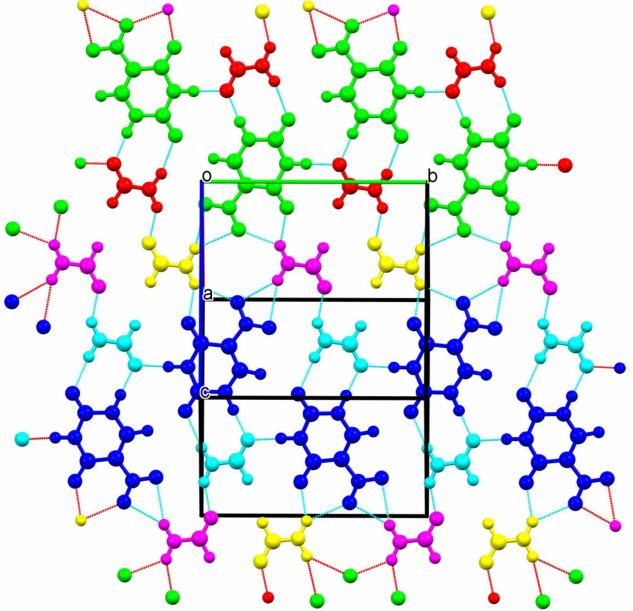
Figure 9. Hydrogen bonded layers in (VIII) with the different colors portraying different residues. In the pyrimidine solvate (IX) of 5NU (Figure 10), the chromophores assemble in chains forming the M7 motif. In this arrangement, the molecular dipoles do not cancel within the chain but wipe out in the unit cell due to a center of symmetry that relates similar chains. The quantitative descriptors for the patterns containing only one type of hydrogen bond (first or primary level hydrogen-bonding) are C (6), C (6) and D (2).